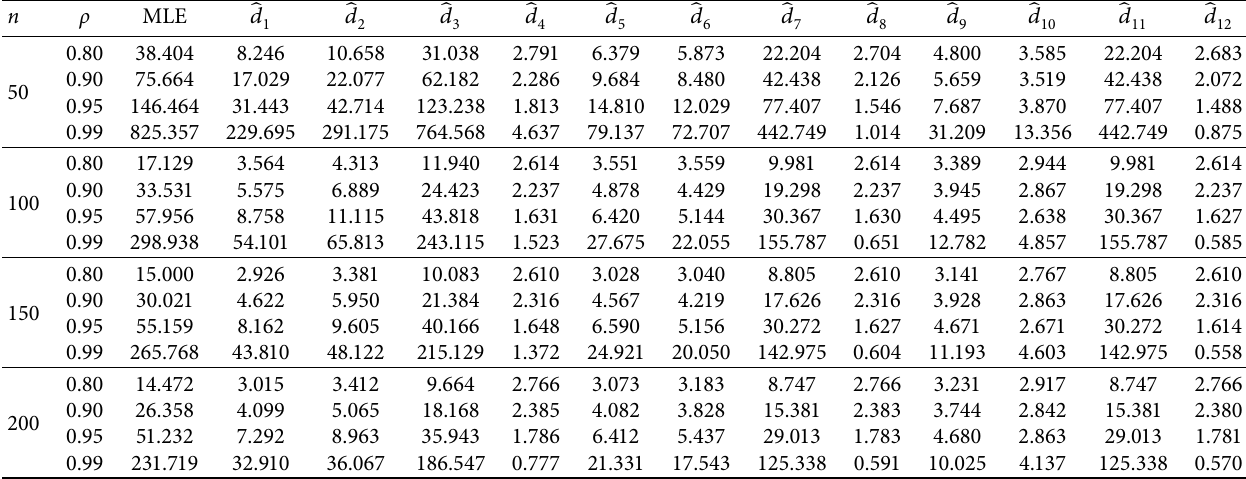
Table 11: Estimated MSEs of the COMPRM estimators, when p � 12 and ϑ �